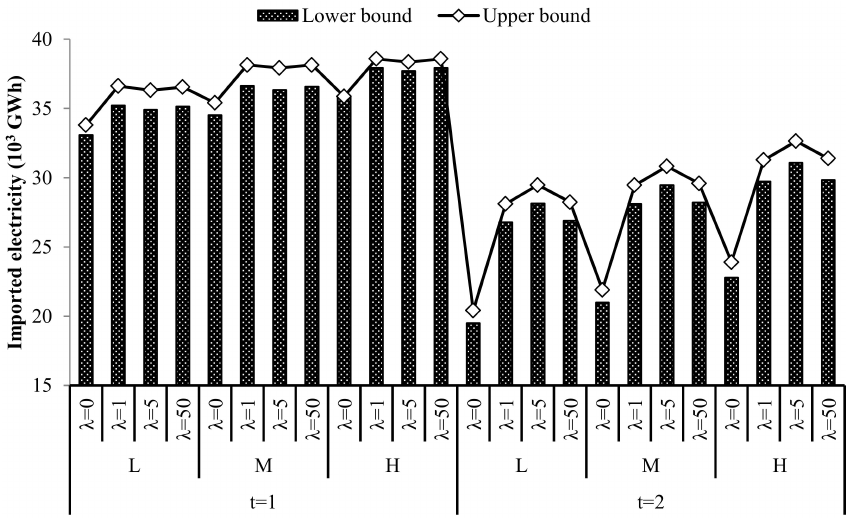
Figure 6. The imported electricity amount under different λ values.